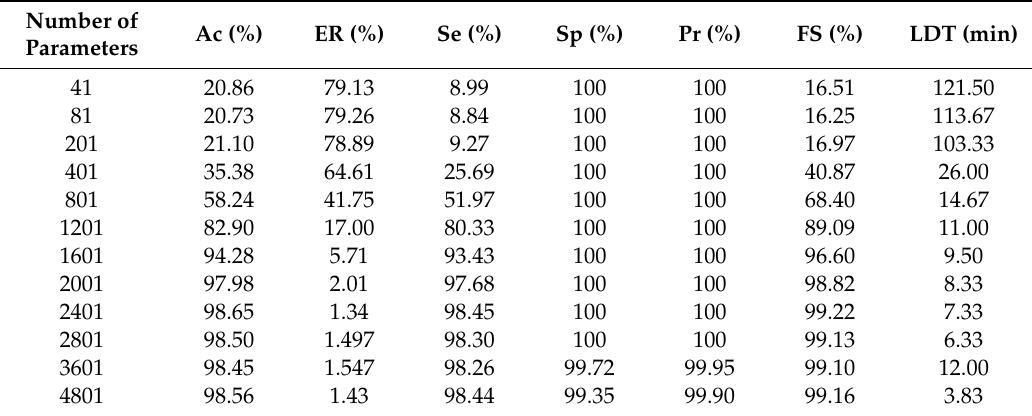
Table 5. Leak detection system performance measures with several parameters at 45 km, leak size was 5% of the nominal flow and, noise ratio was 0.2%. Number of